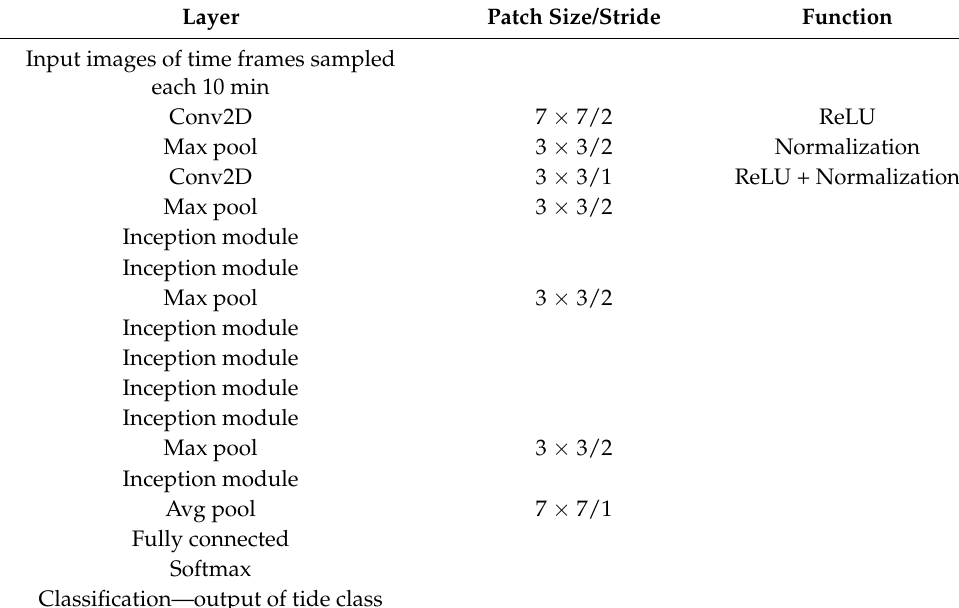
Table 2. Structure of GoogleNET modified for LEUCOTEA to assess the tide classes from video records.